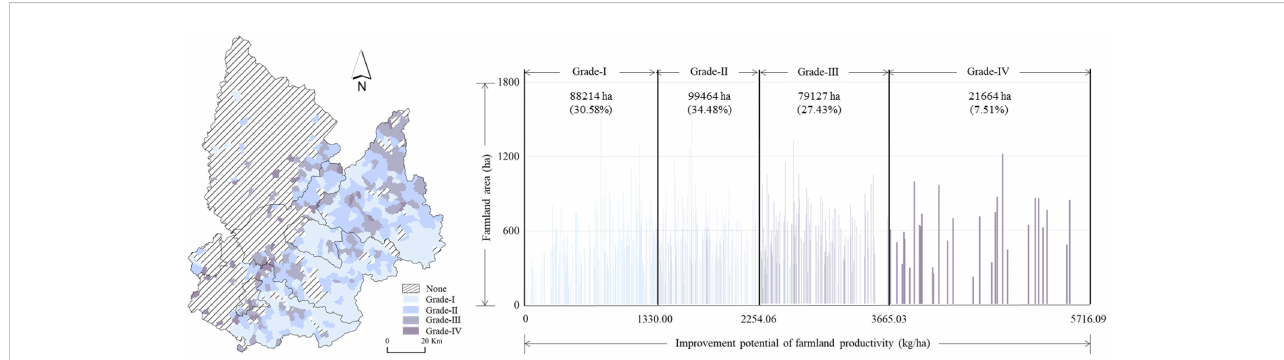
FIGURE 5 Grades of improvement potential of farmland productivity after FCAM. FCAM, farmland consolidation suitable for agricultural